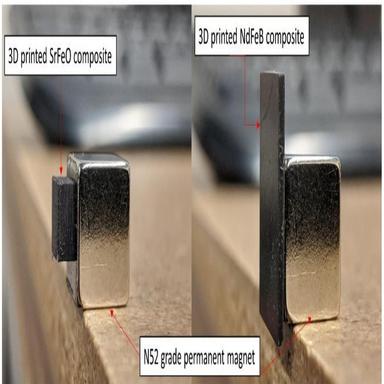
3D printed magnetic composites attracted to the surface of N52 grade permanent magnets.